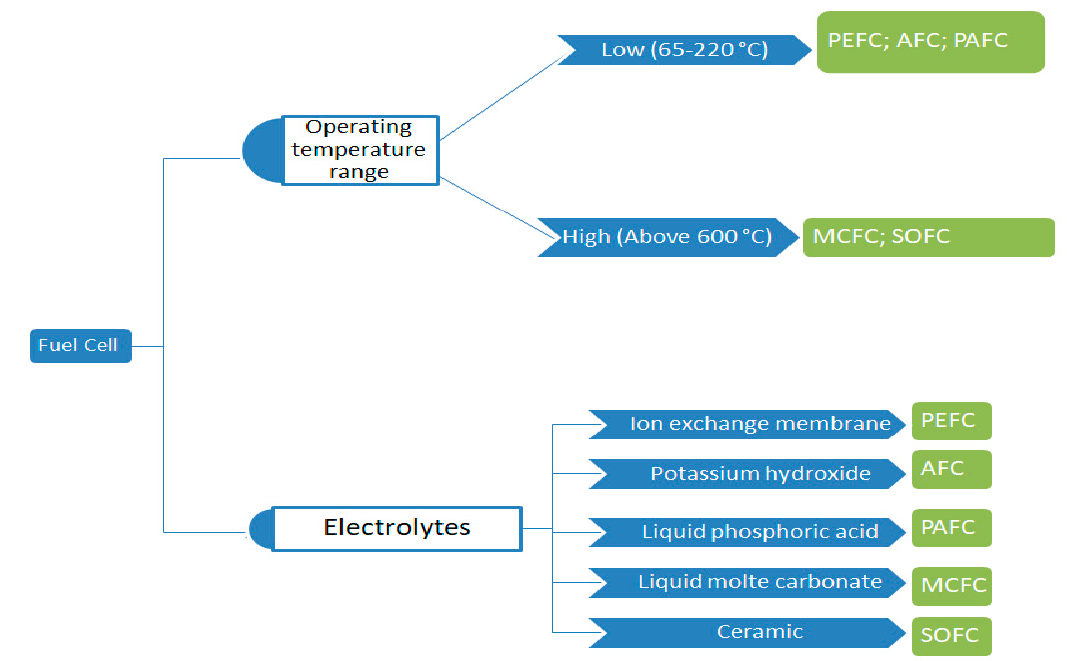
Figure 14. Classifications of fuel cells.